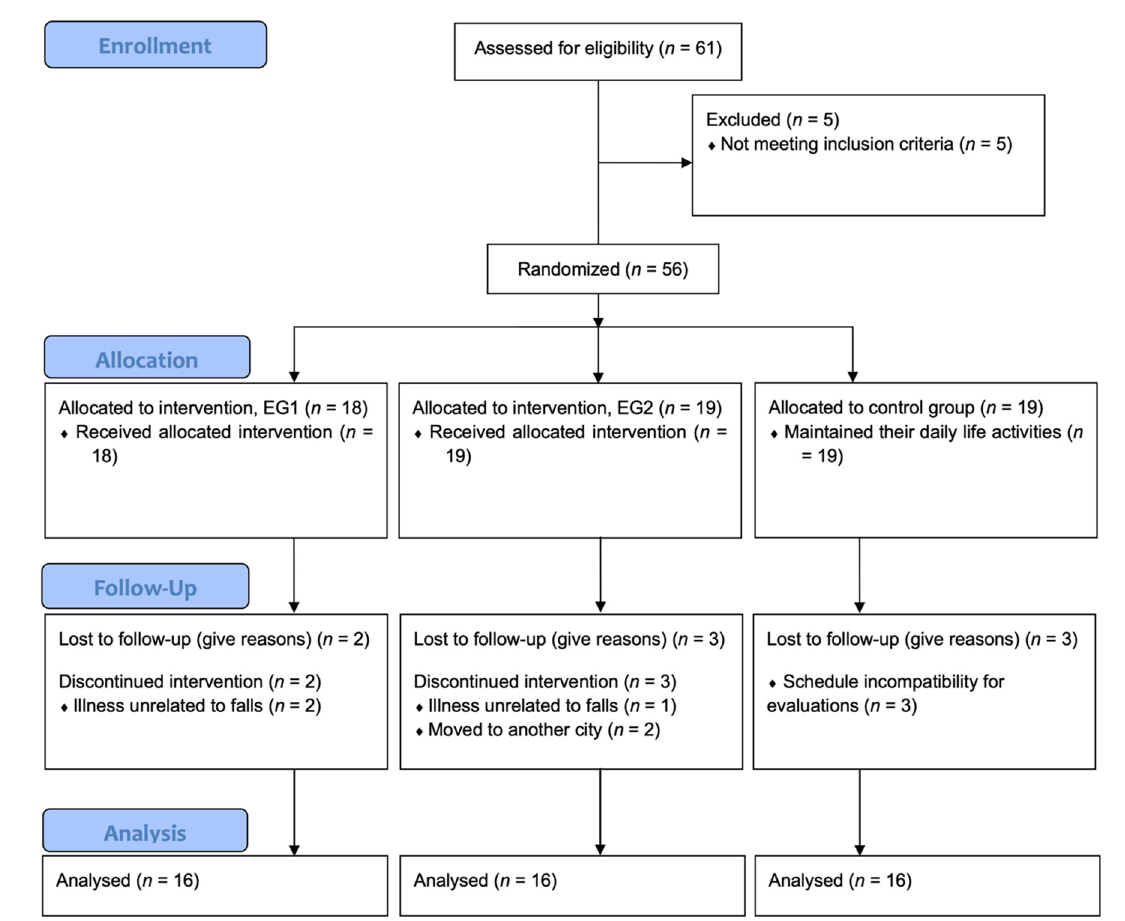
Figure 1. Flow diagram of the study participants.